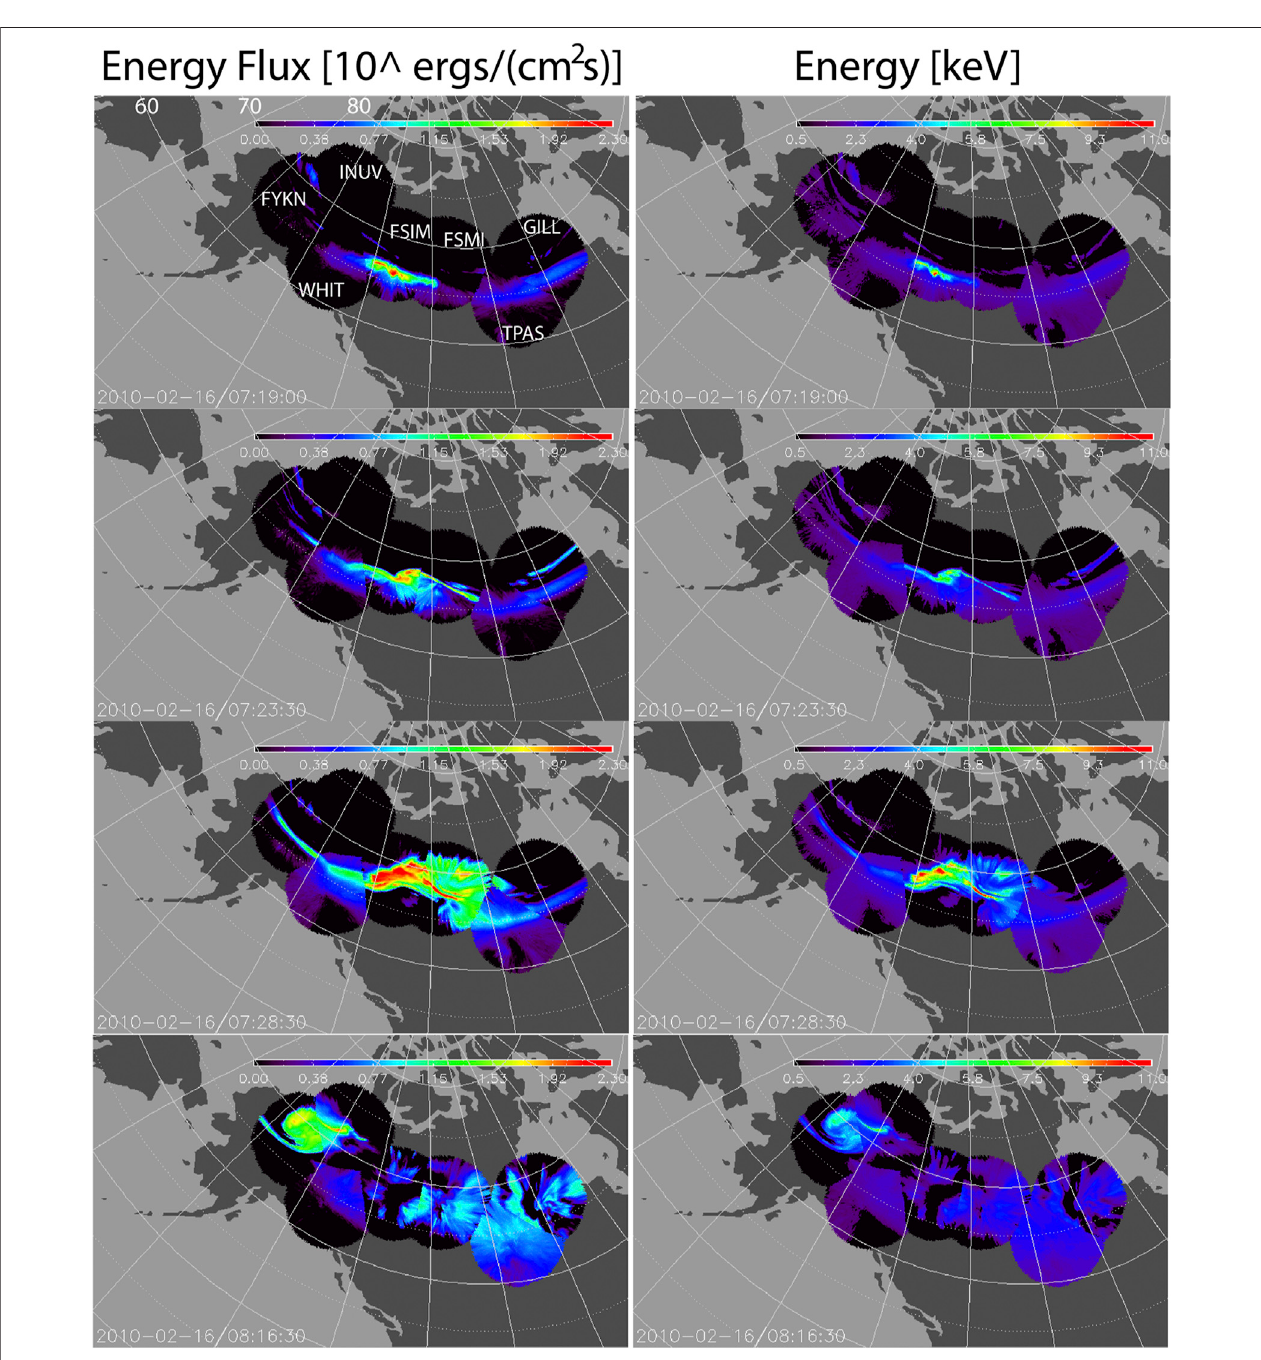
FIGURE 6 | Snapshots in time shortly after substorm onset through substorm poleward expansion and westward traveling surge. Left column: Energy fl ux (plottedlogarithmically)from1 – 200erg cm − 2 s − 1 . Rightcolumn: Averageenergy(plottedlinearly)from0.5 – 11 keV.Magneticlatitudesandstationnamesaremarkedin the fi rst